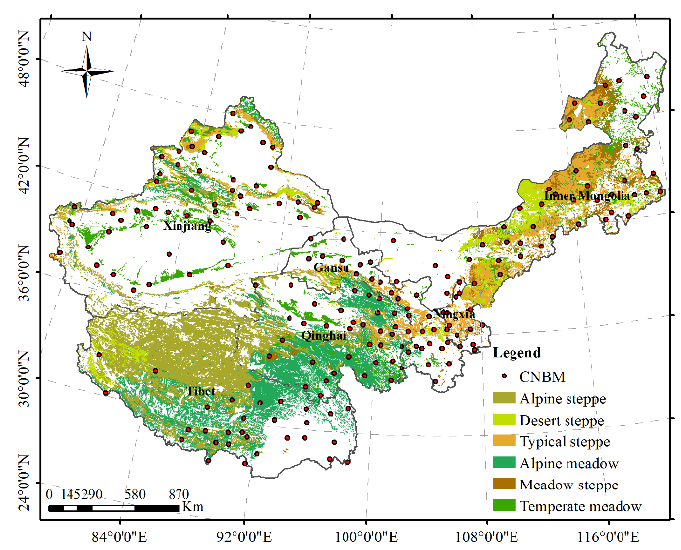
Figure 1. The study area is primarily located in the northwestern part of China.